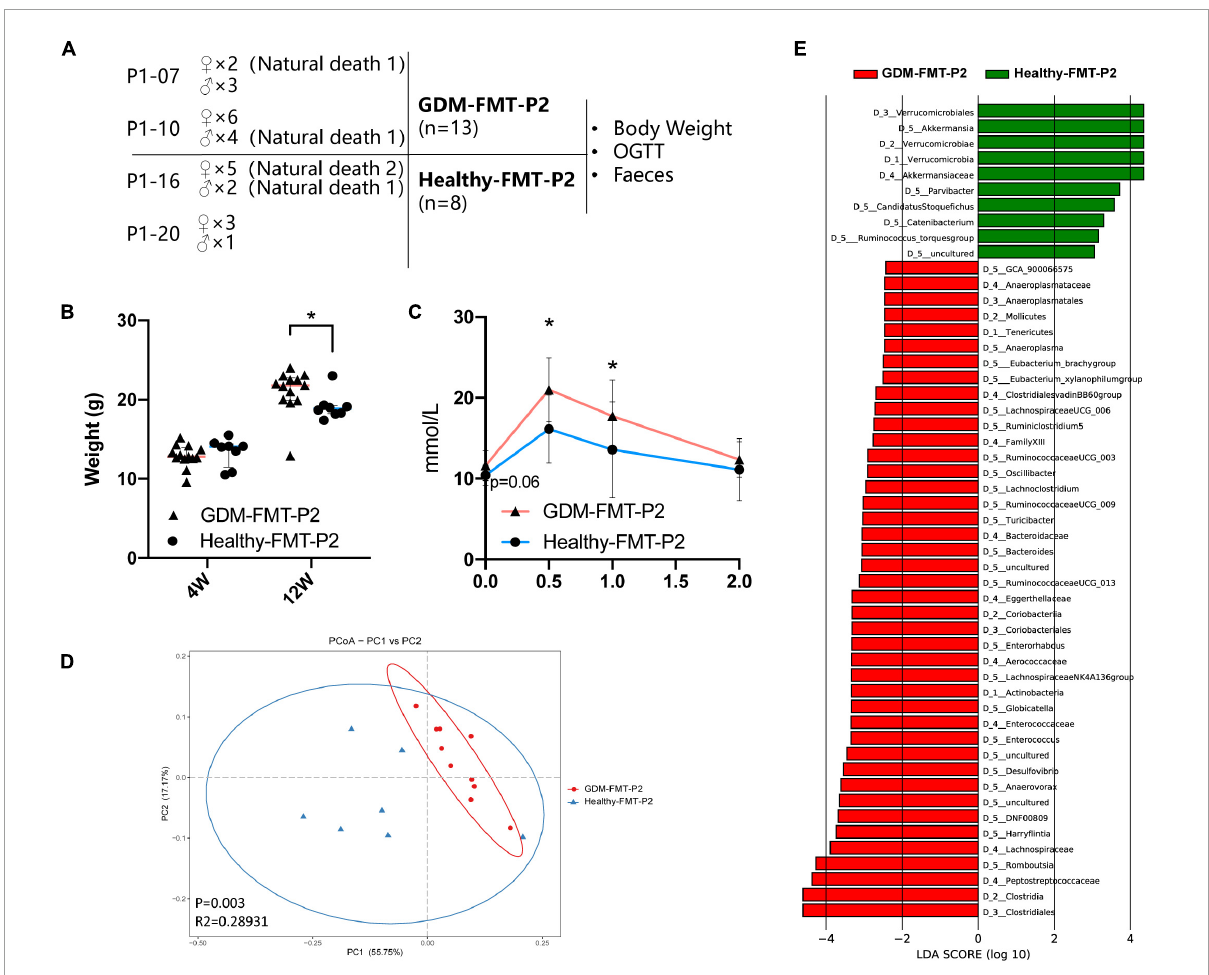
FIGURE5 Construction of offspring mouse model and phenotypic characteristics. (A) Schematic diagram of the offspring mouse model. (B) Scatter plot showing the weight of offspring at different ages. (C) The line chart shows the results of the 12-week-old IPGTT. (D) PCoA at the genus level based on Bray − Curtis distance is shown along the first two principal coordinate (PC) axes with Adonis p -values. (E) Through LDA analysis, the LDA scores of the microbial groups with significant effects in different groups are counted, showing the biomarker with significant differences, and the length of the histogram represents the impact of significantly different species. The healthy FMT-P2 group with a positive LDA score is shown in green. The GDM-FMT-P2 group with a negative LDA score is shown in red (cutoff value ≥ 2; p < 0.05). The numbers and letters in front of the bacteria represent classifying organisms markers: D_1: represents “Phylum,” D_2: represents “Class,” D_3: represents “Order,” D_4: represents “Family,” D_5: represents “Genus.” * p < 0.05.